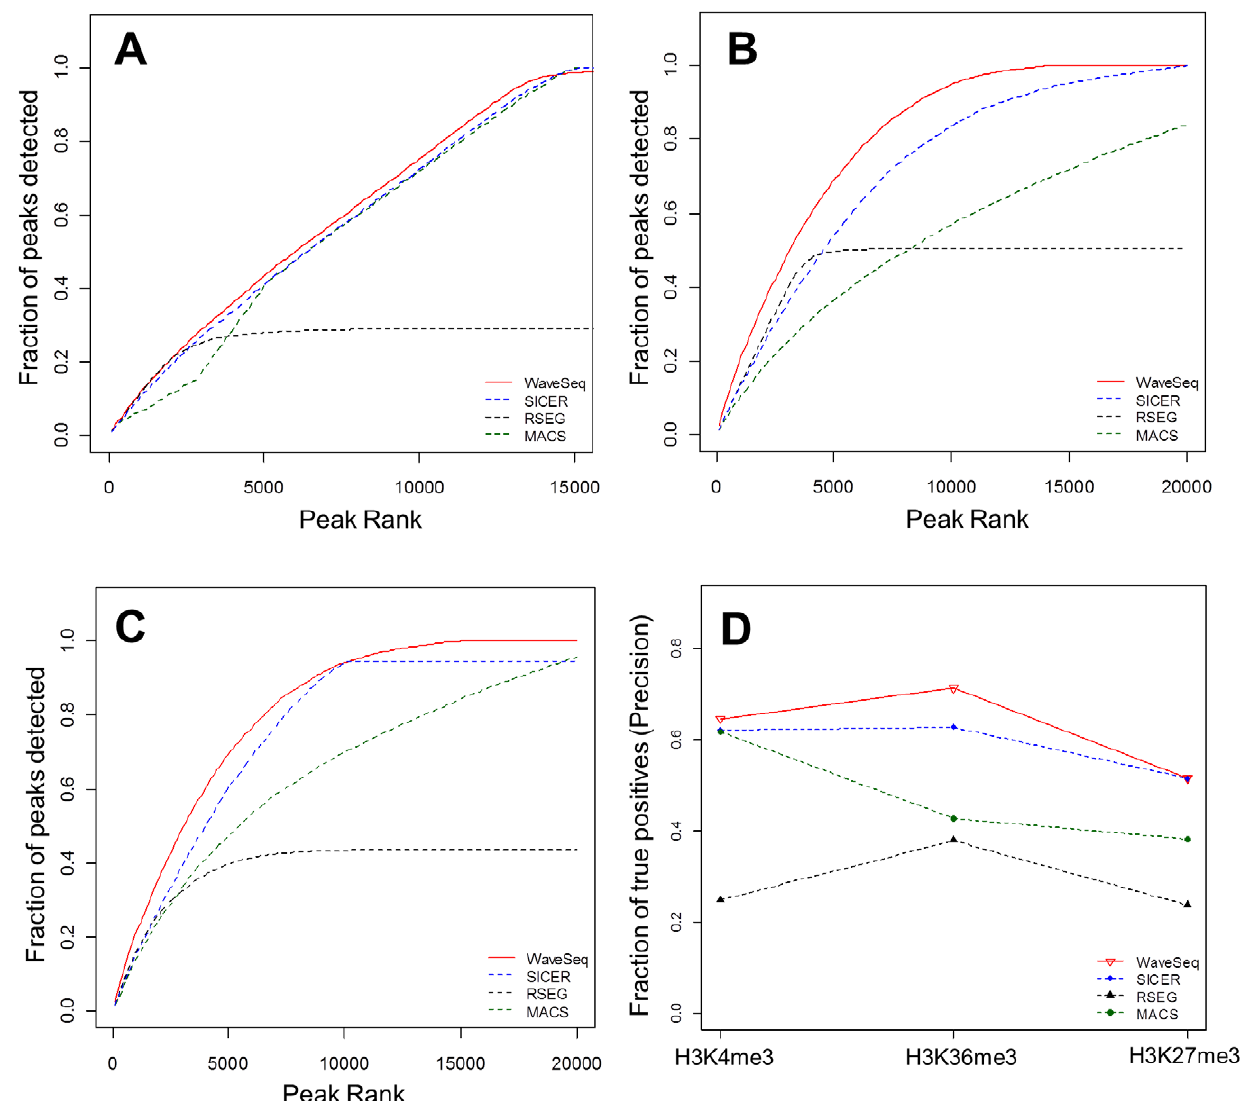
Figure 3. WaveSeq improves detection of histone modification peaks. (a, b & c) Plots of peak ranks against the fraction of putative ‘true positive’ sites detected by WaveSeq, SICER, RSEG and MACS for the (a) H3K4me3, (b) H3K36me3 and (c) H3K27me3 data sets. All methods apart from RSEG perform comparably on the punctate H3K4me3 data. However, WaveSeq outperforms the other methods on the broader peaks of H3K36me3 and H3K27me3. SICER comes in second while MACS has low sensitivity for diffuse data. RSEG has good sensitivity for the strongest peaks but suffers from low recall, failing to detect any peaks in chromosomes 10–19. (d) A plot of the fraction of true positives (precision) from the top 10000 peaks detected by the above four methods in the MEF histone modification data sets shows that WaveSeq has the best performance, closely followed by SICER. MACS performs well only on the H3K4me3 data while RSEG has low precision for all the three data sets.